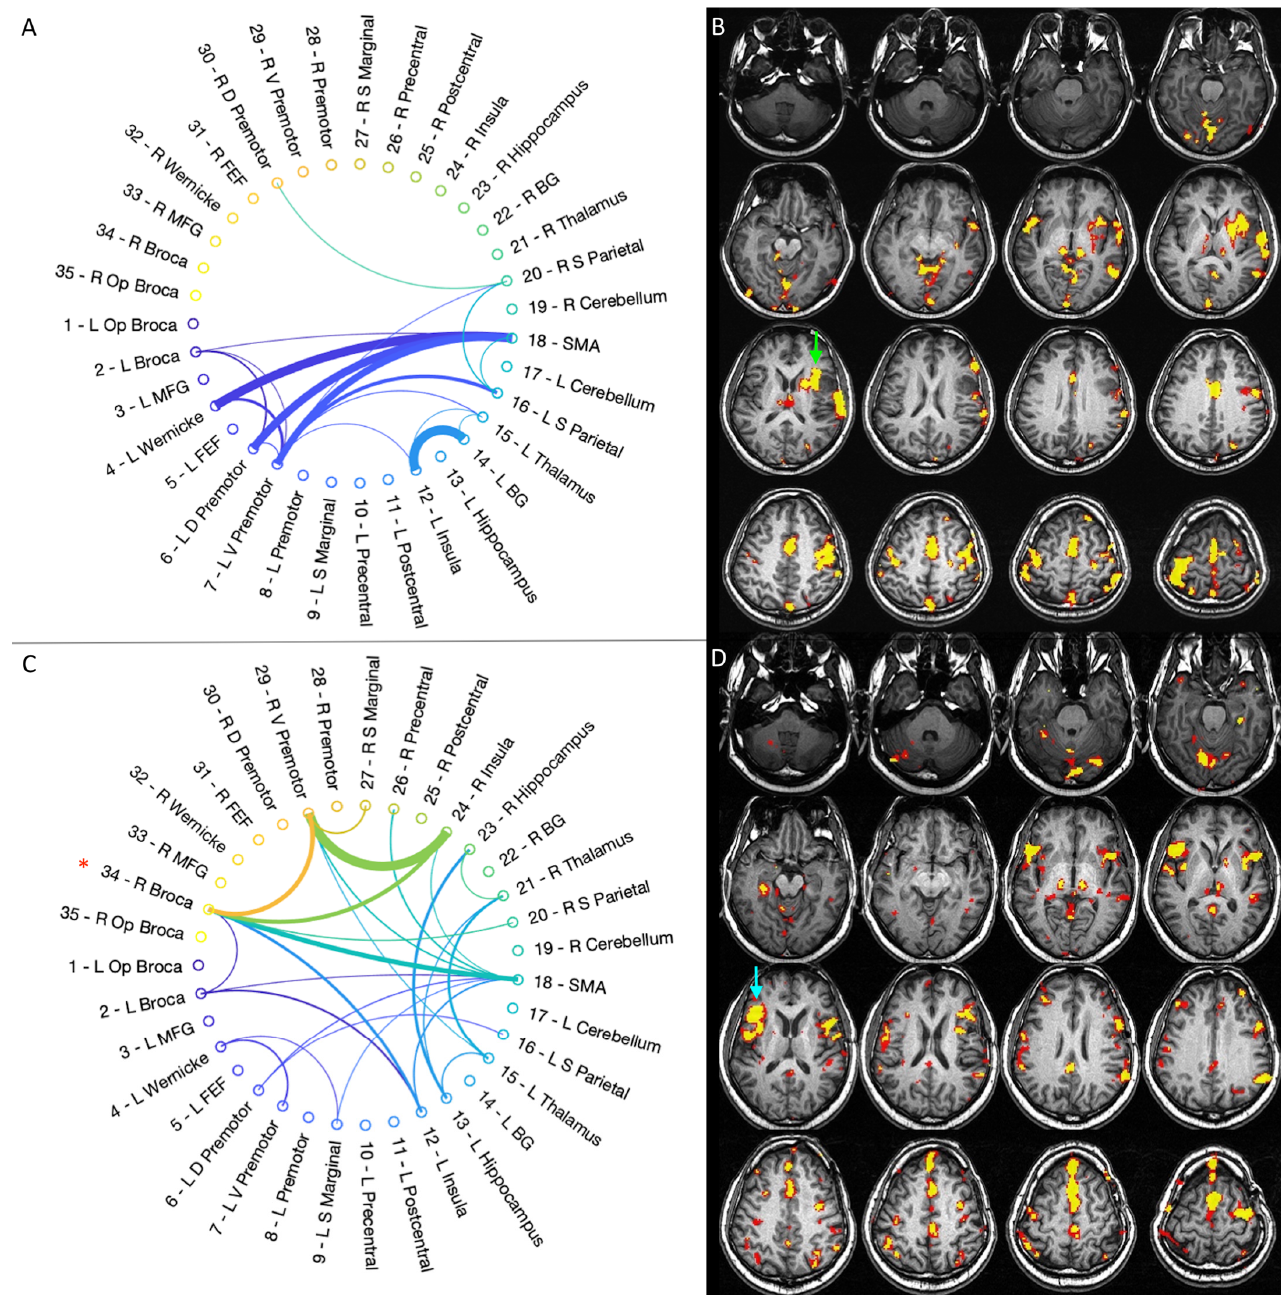
Figure 2. Representative case for type 1 language reorganization. The images on top show the connectivity diagram ( A ) and fMRI activation map obtained with letter task ( B ) at the first timepoint (pre-op). The patient was left-dominant on the preoperative fMRI, with strong activation of Broca’s area (green arrow in ( B )). The connectivity diagram mirrors this finding, showing predominant left-hemispheric connections. The images at the bottom show the connectivity diagram ( C ) and fMRI activation map obtained with letter task ( D ) at the last timepoint (post-op3). The patient displayed right-dominance on fMRI, with strong activation of right Broca’s area homologous (light blue arrow in ( D )). The connectivity diagram shows increased inter-hemispheric and right-side connections, including Broca’s area homologous (red asterisk in ( C )). This type of reorganization was found in case 1, 3, 4.